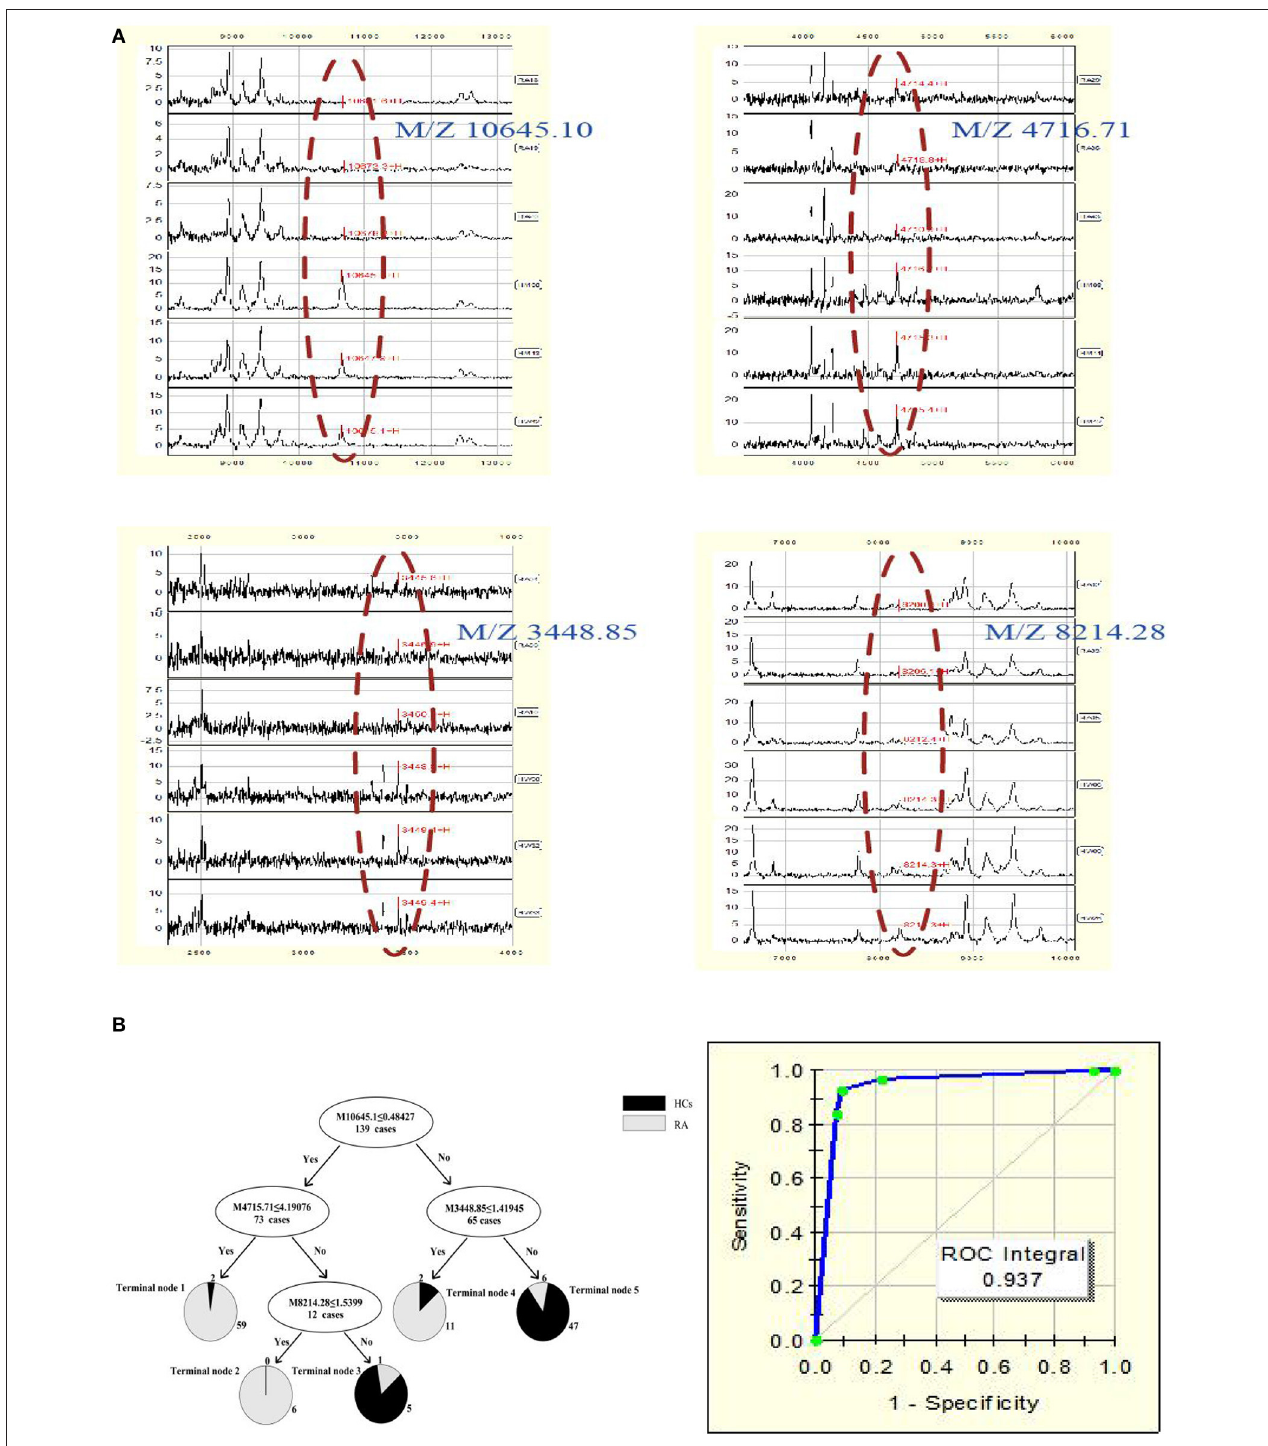
FIGURE 1 | (A) Serum protein/peptide spectrum of RA patients and HCs. (B) Dot plots and ROC curve of selected biomarker candidates in patients with RA and healthy controls. The mass-to-charge value in the nodes was followed by lower or equal to intensity value. If the answer to the question in a node of the tree was yes, it proceeded down to the left node, otherwise it proceeded down to the right node. When samples allocated to terminal node 1, 2, and 4 were assigned as RA, whereas those classified into terminal node 3 and 5 were assigned as HCs.